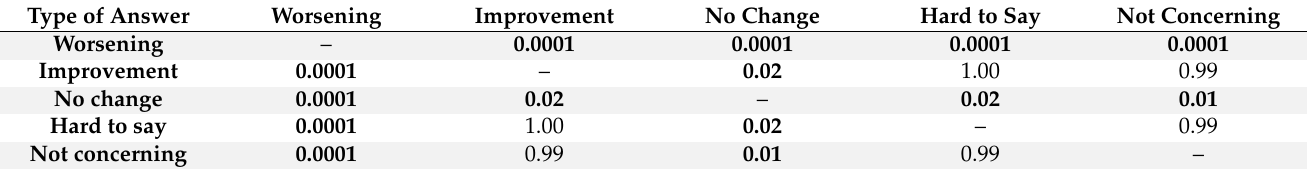
Table 4. Differences between the overall number of respondents for each answer in questions related to the impact of the COVID-19 pandemic on